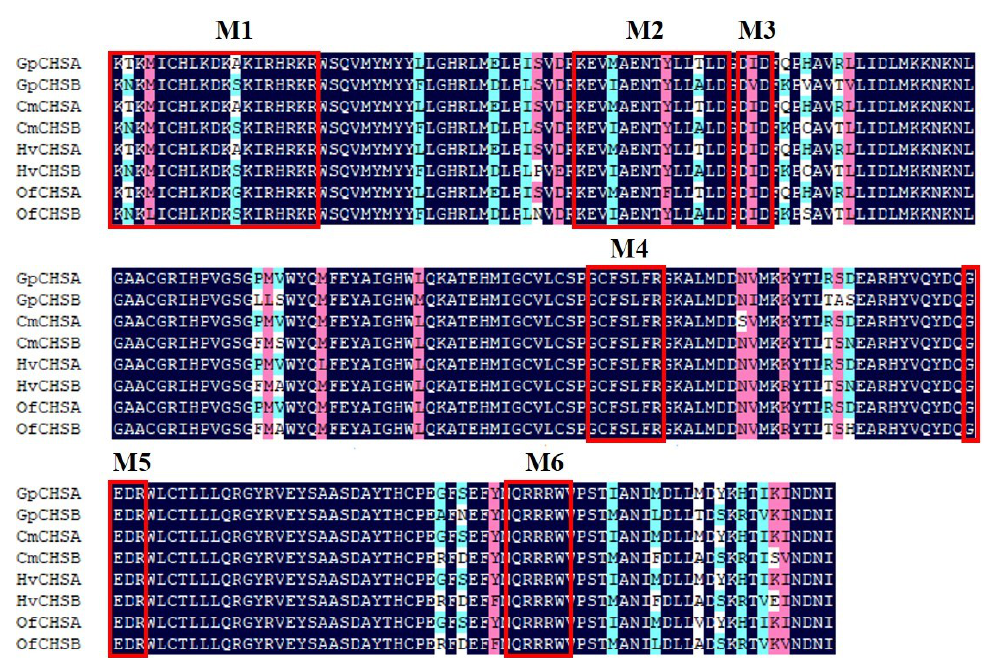
Figure 1. The analysis of putative catalytic functional domains of chitin synthases (CHSs) among different Lepidoptera insects based on the multiple sequence alignment. Dark blue represents identical amino acids. Pink and aqua represent positively charged amino acids. Non-conserved positions have a white background. Six characteristic motifs M1-6 of highly conserved regions of glycosyltransferases (family 2) enzymes were shown in red boxes [22,29]. Cm, Cnaphalocrocis medinalis , CmCHSA, AJG44538.1, CmCHSB, AJG44539.1; Hv, Heortia vitessoides , HvCHSA, AZQ19982.1, HvCHSB, AZQ19981.1; Of, Ostrinia furnacalis , OfCHSA, ACF53745.1, OfCHSB, ABB97082.1.